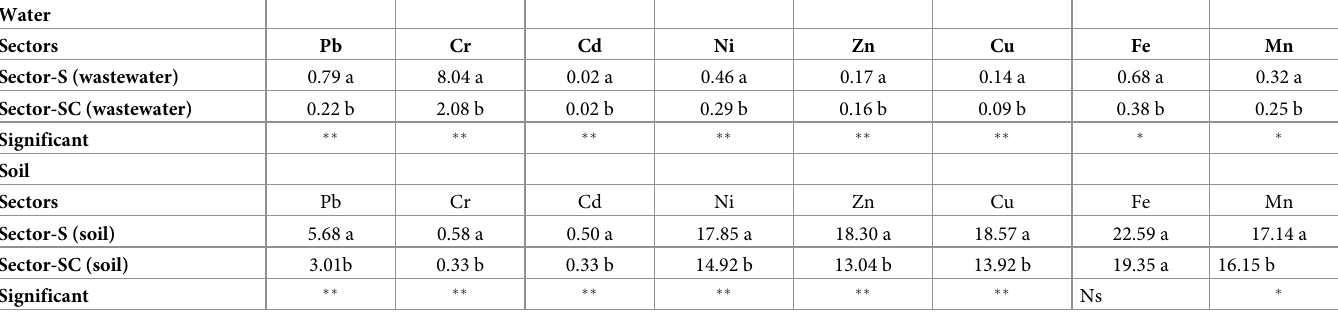
Max stands for maximum, Min for minimum, SD for standard deviation.